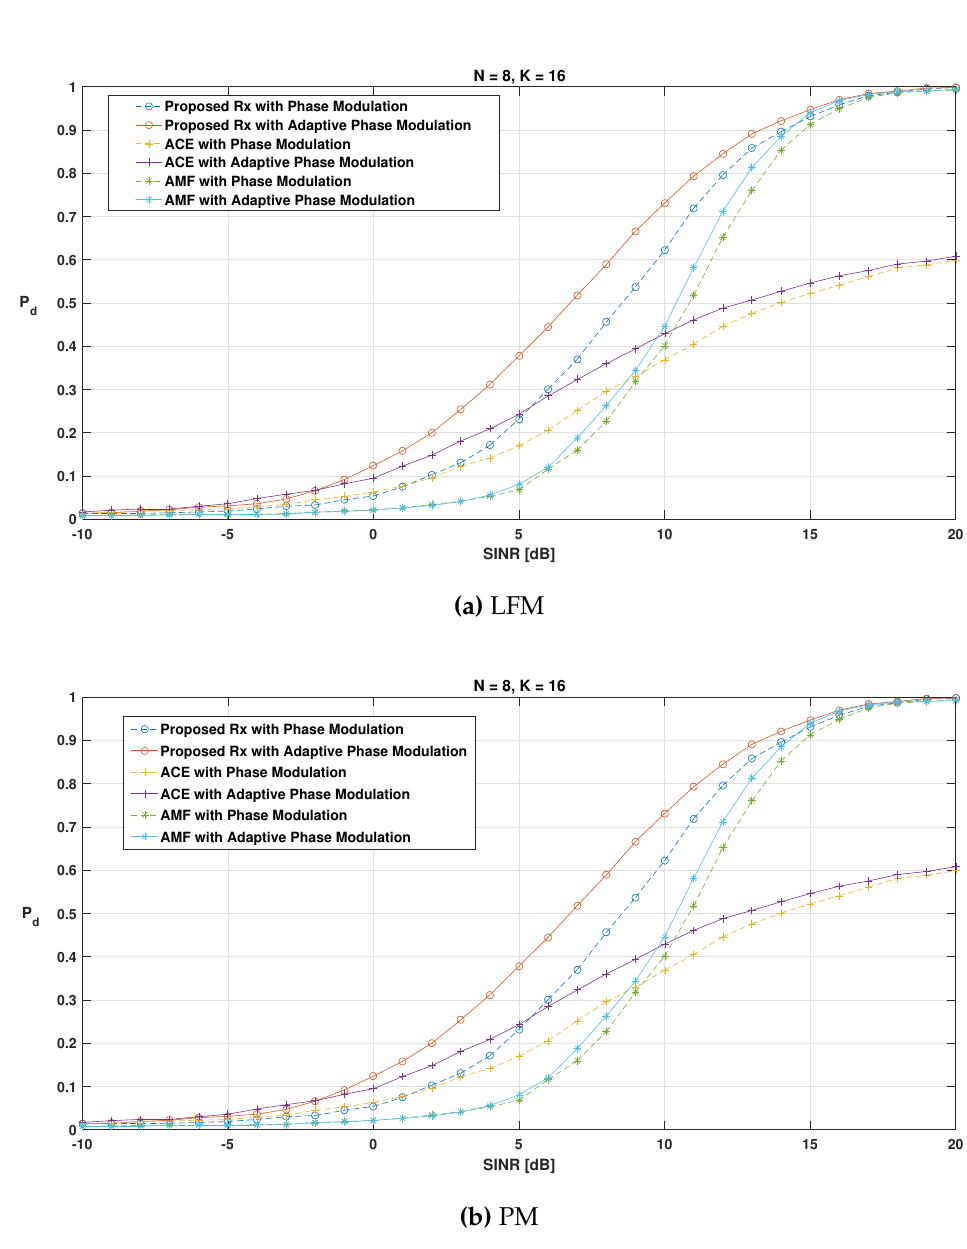
Figure 5. P d versus SINR curves at the end of Sub-dwell 1 (LFM) and using adaptive phase modulated waveform design in Sub-dwell 2 (APM); N = 8, K = 16, P fa = 10 − 2 , L =